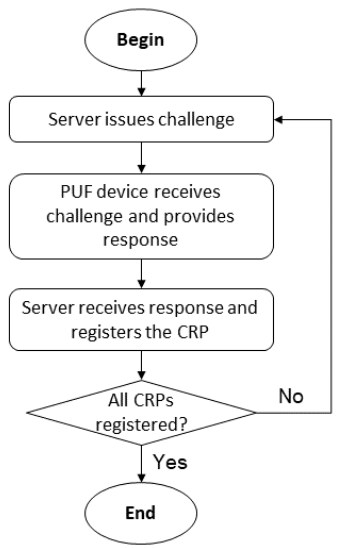
Figure 7. PUF challenge response pairs laborious offline registration